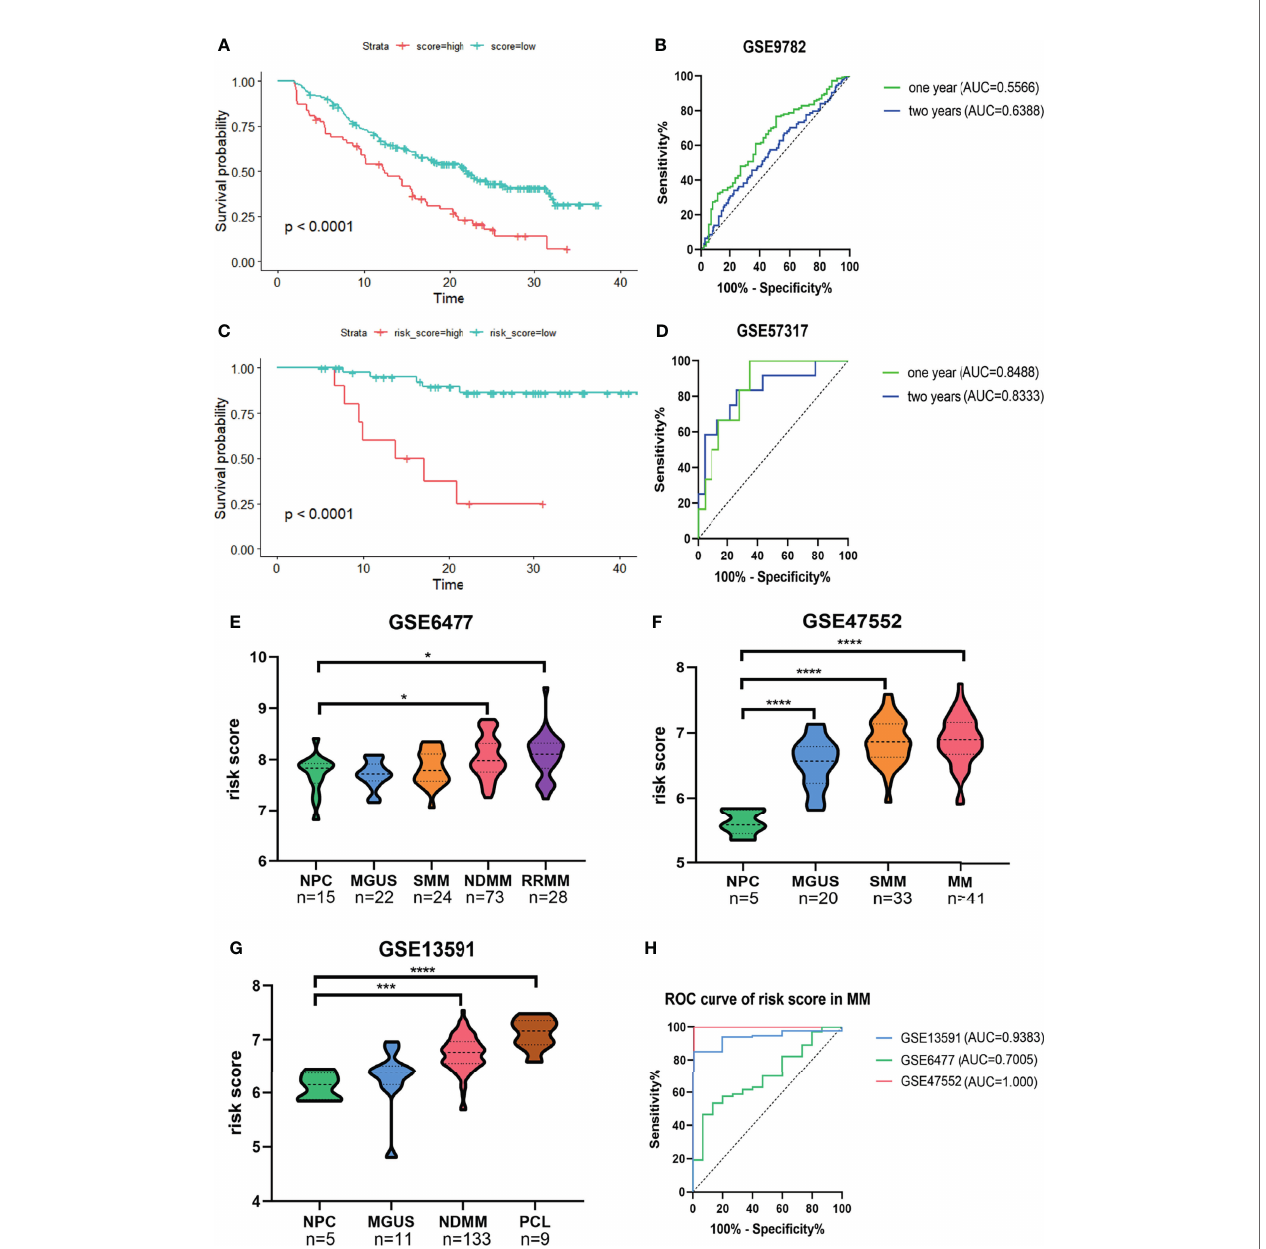
FIGURE 3 | Con fi rmation of the predictive performance of risk signature for MM prognosis and diagnosis in validation cohorts. (A, B) Kaplan-Meier survival analysis and ROC curve in the GSE9782 dataset. (C, D) Kaplan-Meier survival analysis and ROC curve in GSE57317 dataset. (E – G) The risk score levels of the continuous disease spectrum in MM datasets GSE6477 (E) , GSE47552 (F) and GSE13691 (G) . (H) ROC curves of risk score in MM to assess the diagnostic ef fi ciency. *P<0.05, ***P<0.001,